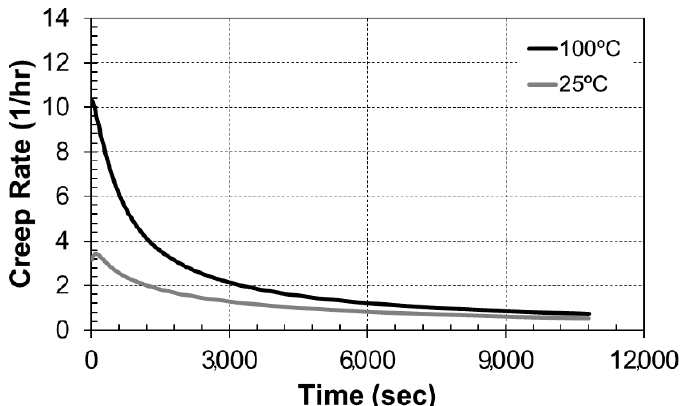
Figure 17. Creep rate as a function of time for a nanocomposite made of 15 v% cellulose and 0 wt. % STO nanoparticles.